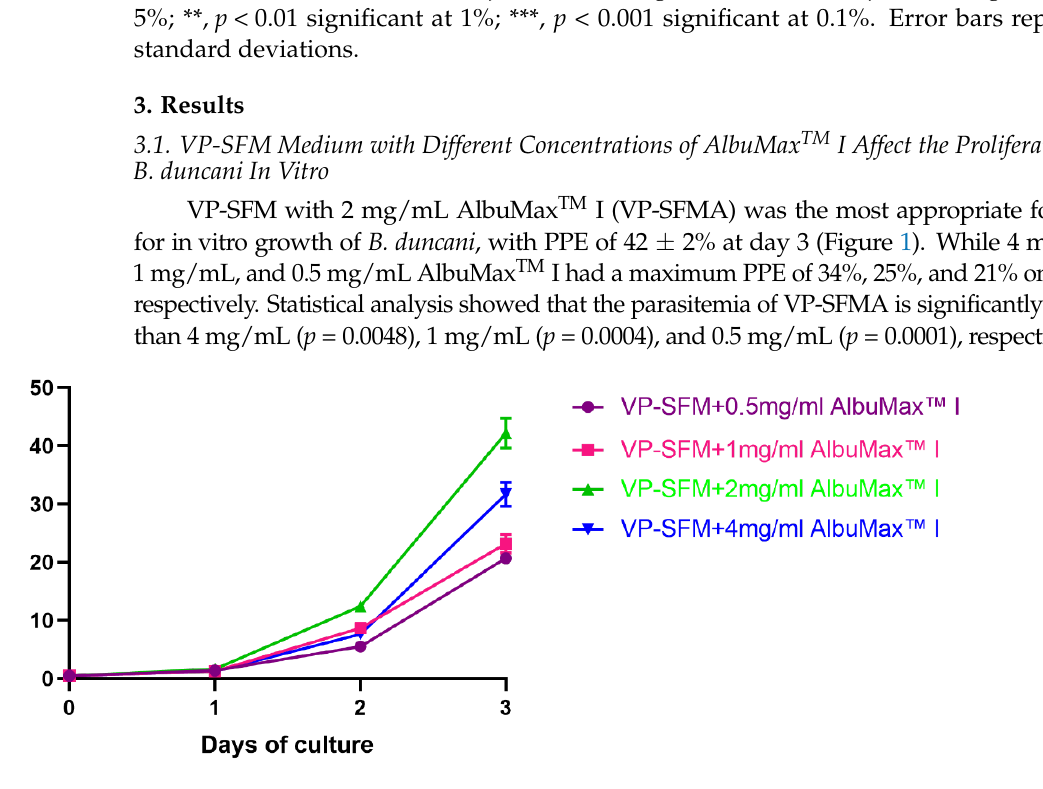
Figure 1. In vitro culture of B. duncani in VP-SFM supplemented with different concentrations of AlbuMax TM I. Mean values from three separate experiments using triplicate wells for each test concentration were represented. PPE: percentage of parasitized erythrocytes.